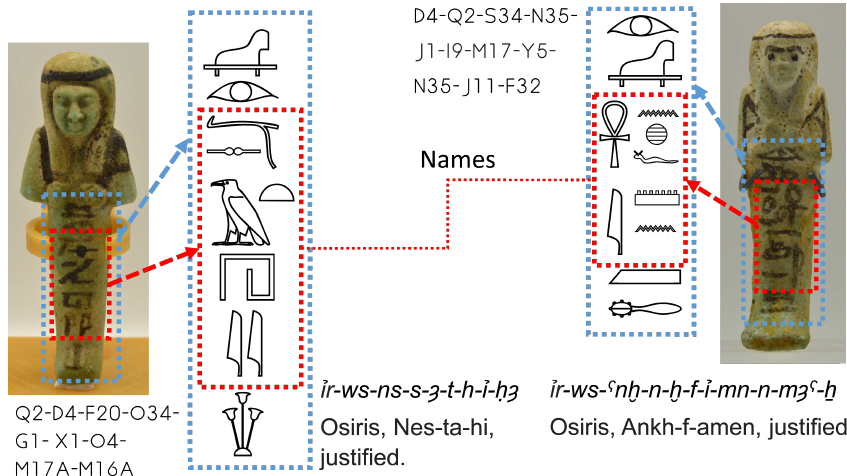
Figure 8. Hieroglyphic inscriptions, using the Gardiner code [40], represent some religious expressions in addition to the names. Private collection.